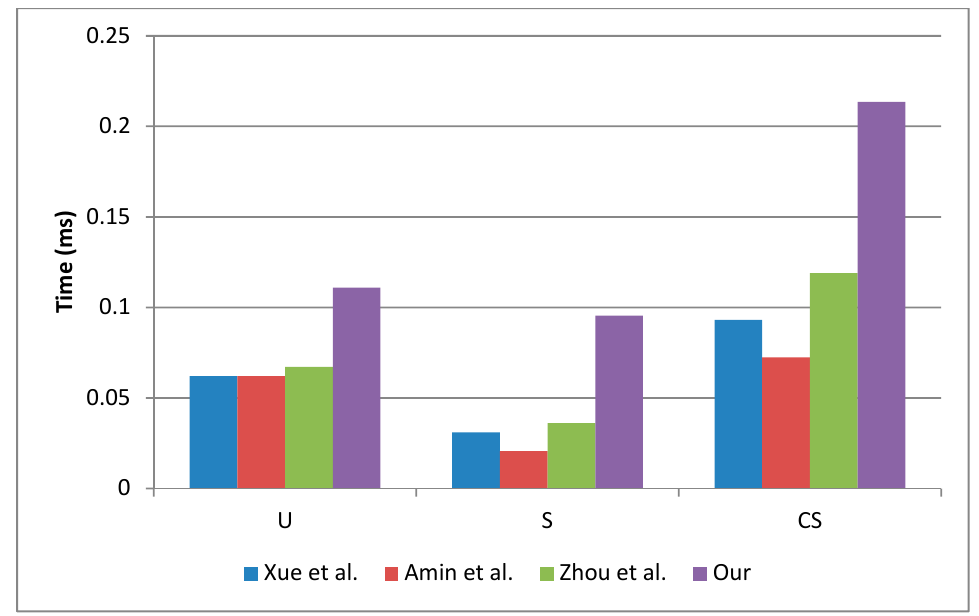
Figure 7. Computational-cost comparison by participant.